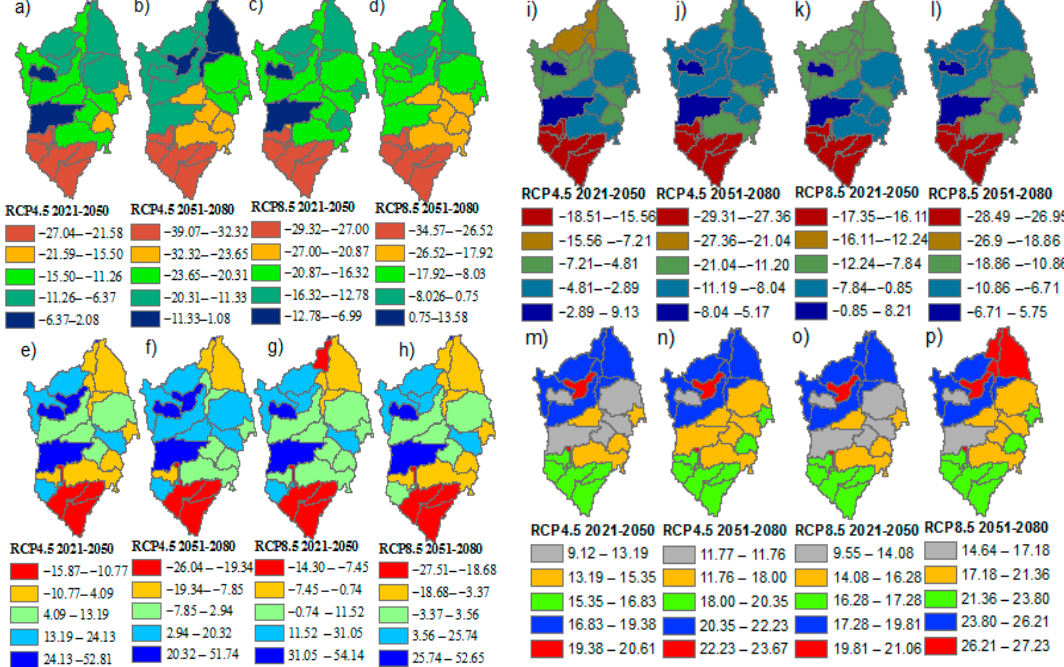
Figure 11. Spatial patterns of the changes in surface runoff ( a , b , c and d ), groundwater ( e , f , g and h ), water yield ( i , j , k and l ) and PET ( m , n , o and p ) due to CC. and PET ( m – p ) due to